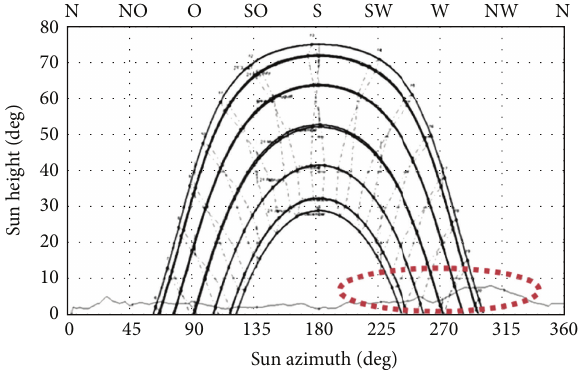
Figure 12: Annual sun paths and surrounding mountains in the selected